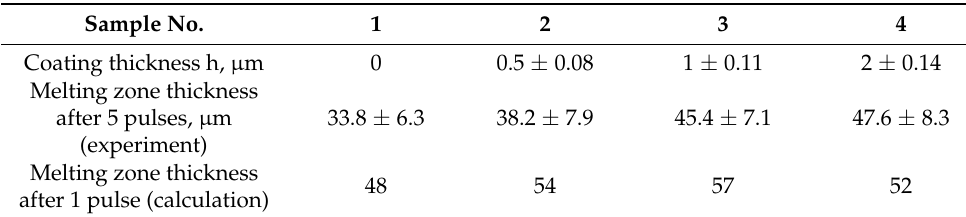
Figure 3. SEM images of the surface structure of silumin without and with a ZrN coating after electron beam treatment: sample 1 (no coating) ( a ), sample 2 ( h ZrN = 0.5 µ m) ( b ), sample 3 ( h ZrN = 1 µ m) ( c ), and sample 4 ( h ZrN = 2 μ m) ( d ). The dotted line marks the zone of melting of all silumin phases. Table 3. Thickness of the melting zone of the bare and ZrN-coated silumin after electron beam treat- ment.